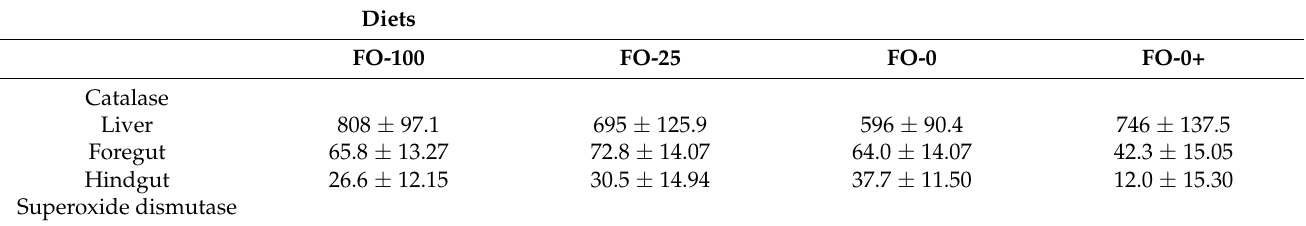
Table 1. Antioxidant enzyme activities 1 in the liver, foregut, and hindgut of Mediterranean yellowtail ( Seriola dumerili ) fed the experimental diets for 109